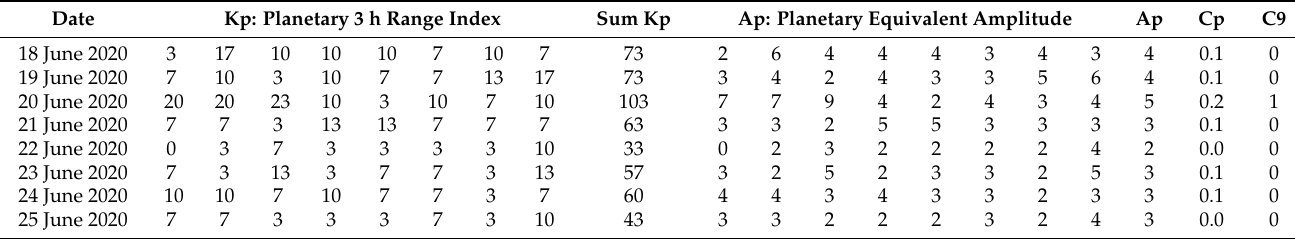
Table 7. Geomagnetic data statistics during the period of 18–25 June 2020 (source: http://www.geomag.bgs.ac.uk/data_ service/space_weather/solar.html (accessed on 6 February